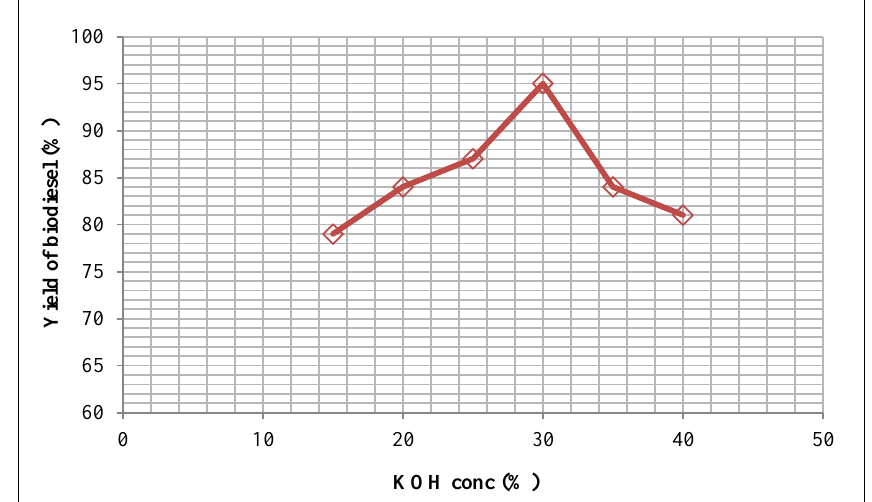
Figure 4. Effect of KOH concentration on biodiesel